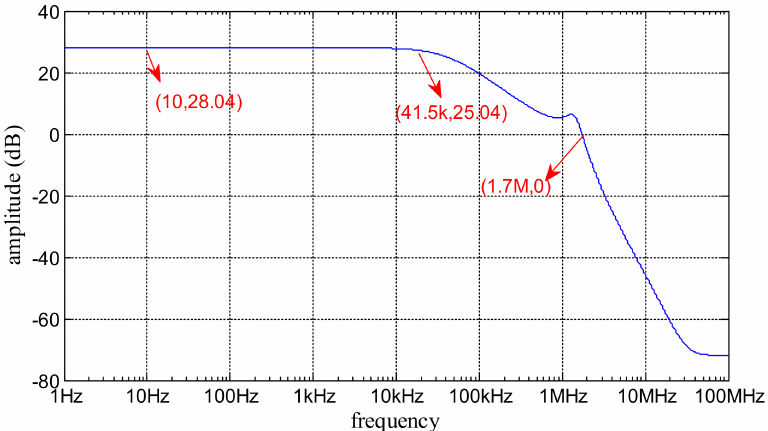
Figure 11. Simulated amplitude-frequency characteristic of the power amplifier using the high- voltage operational amplifier.